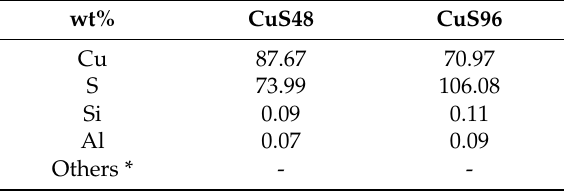
Table 3. Semi-quantitative chemical composition (wt%) of the mineral sulfide samples.